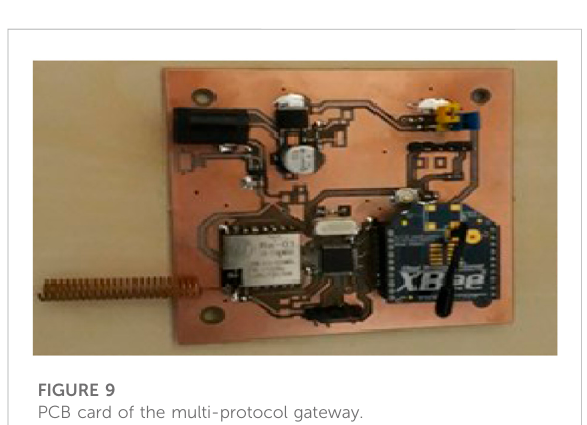
FIGURE 9 PCB card of the multi-protocol